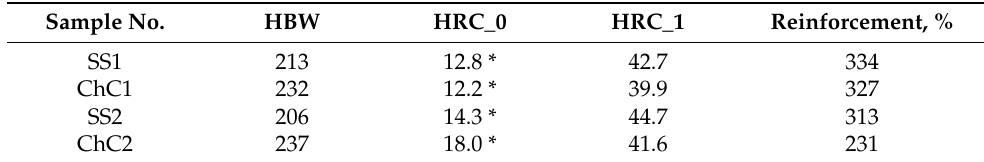
Table 5. Values of Brinell hardness for all samples, followed by Rockwell test on raw (HRC_0) and reinforced regions (HRC_1) of inspected materials. The values marked with asterisk are below the scale of Rockwell test, and are given only for comparative purposes. * conversion value of the HRC scale.